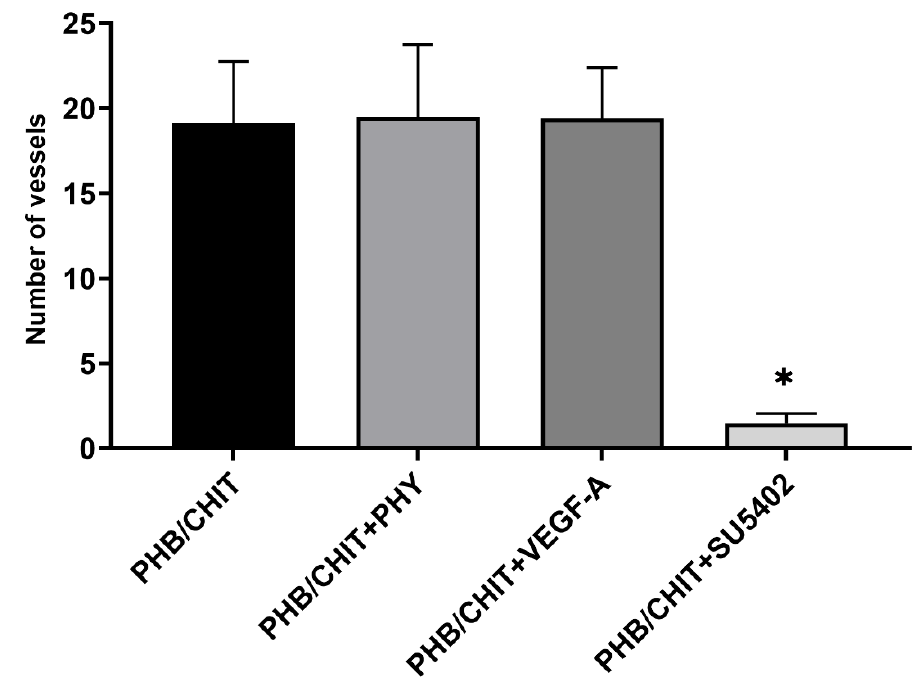
Figure 1. Macroscopic evidence of angiogenic response and in vivo angiogenic activity of PHB/CHIT. Comparison of the average number of newly formed blood vessels in the surrounding area of untreated PHB/CHIT scaffold, scaffold soaked with saline (PHB/CHIT+PHY), vascular endothelial growth factor (PHB/CHIT+VEGF-A), and tyrosine kinase inhibitor (PHB/CHIT+SU5402) showed